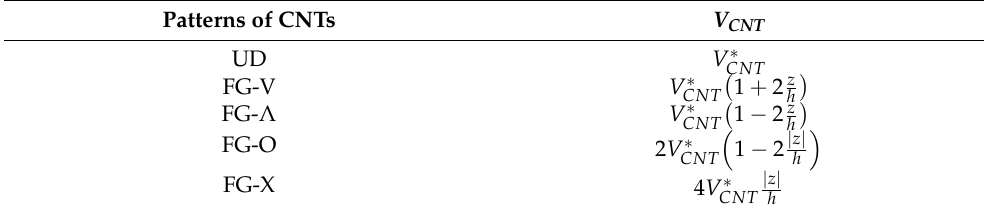
Table 1. Volume fractions of CNTs as a function of thickness direction for different distributions of CNTs [27]. Patterns of